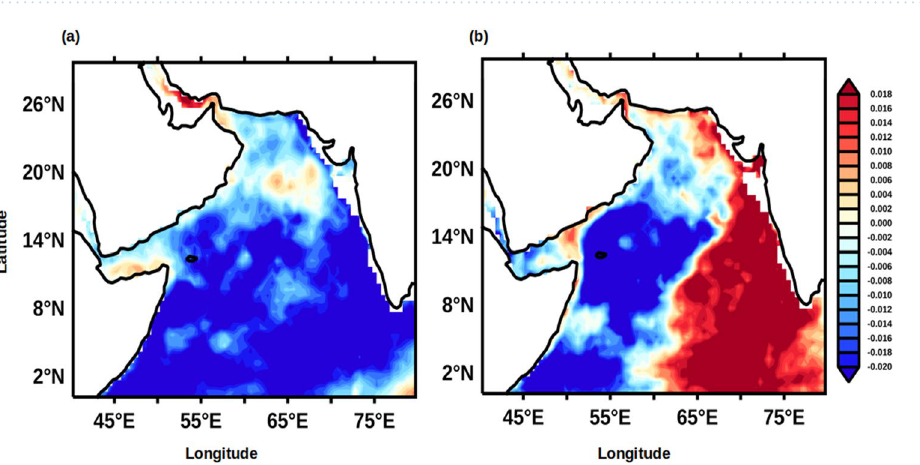
Figure 8. ( a ) The Principal Component 1 and ( b ) Principal component 2 of the EOF of the UOHC during